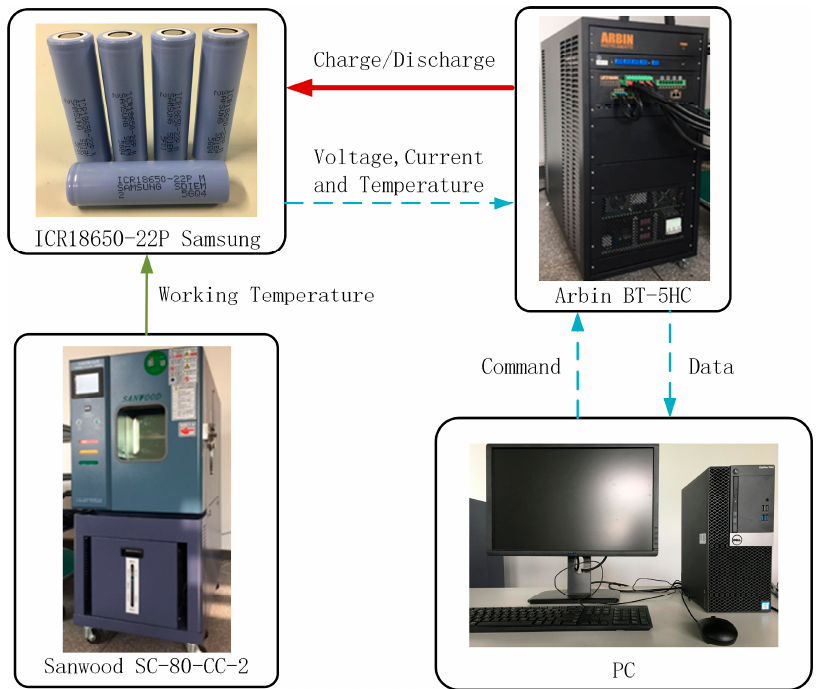
Figure 3. Configuration of the battery test bench.